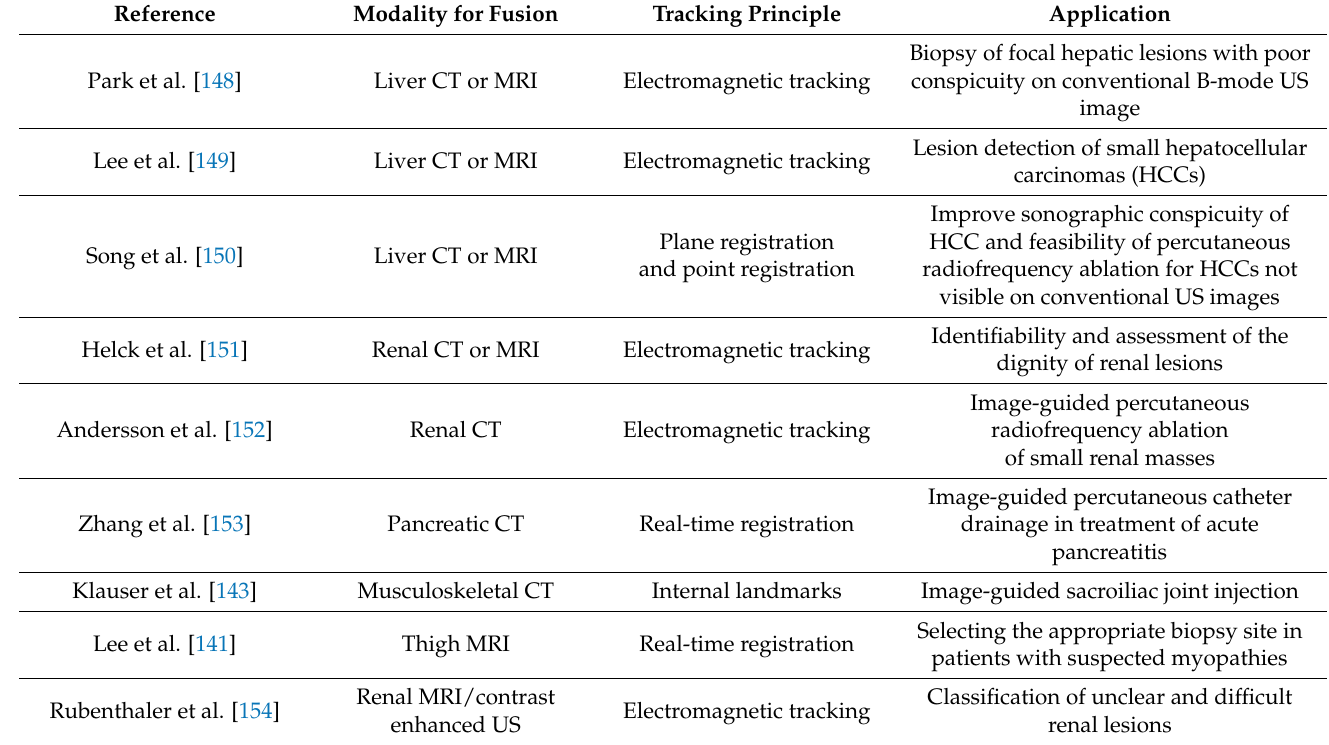
Table 6. A summary of US image fusion applications.